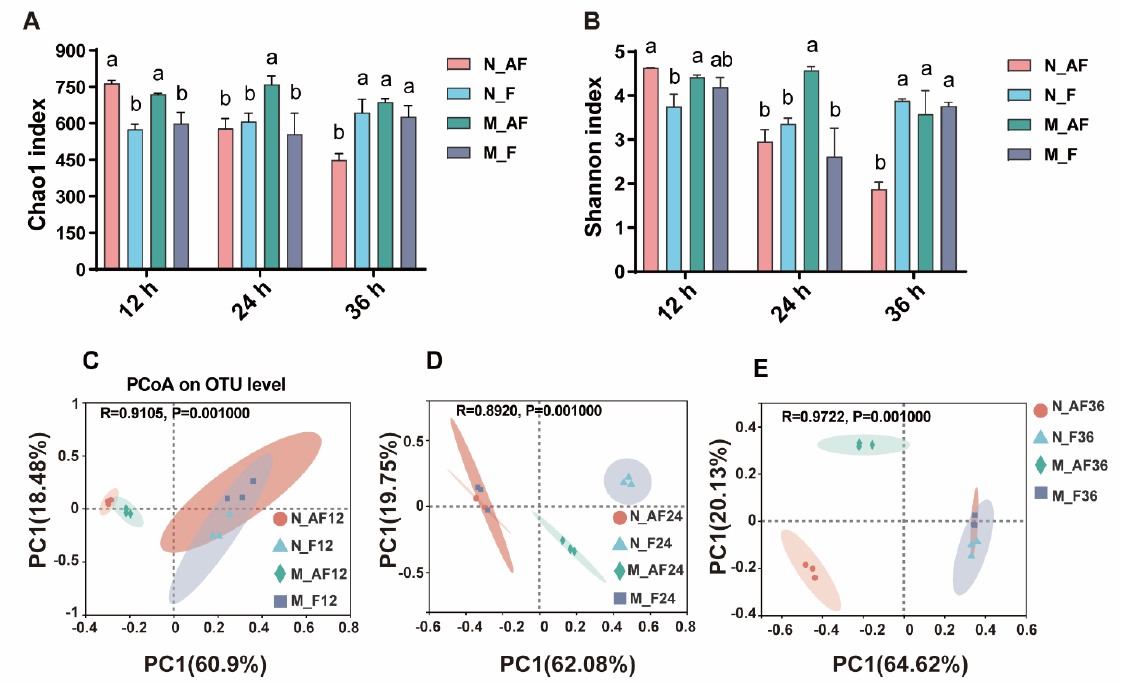
Figure 5. Bacterial diversity during fermentation. Chao1 ( A ) and Shannon ( B ) indexes in the fermentation broth at 12h, 24h, and 36h. PCoA analysis during fermentation of 12 h ( C ), 24 h ( D ) and 36 h ( E ). Data are represented as mean ( n = 3; Different letters mean p < 0.05). N_AF, normal medium with anti-frozen inoculum; N_F, normal medium with frozen inoculum; M_AF, modified medium with anti-frozen inoculum; M_F, modified medium with frozen inoculum.